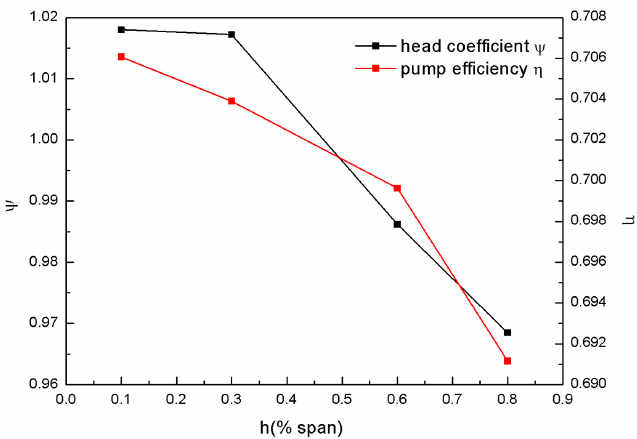
Figure 10. Axial-flow pump performance with varying tip clearance at φ = 0.354 . Energies 2018 , 11 , x FOR PEER REVIEW